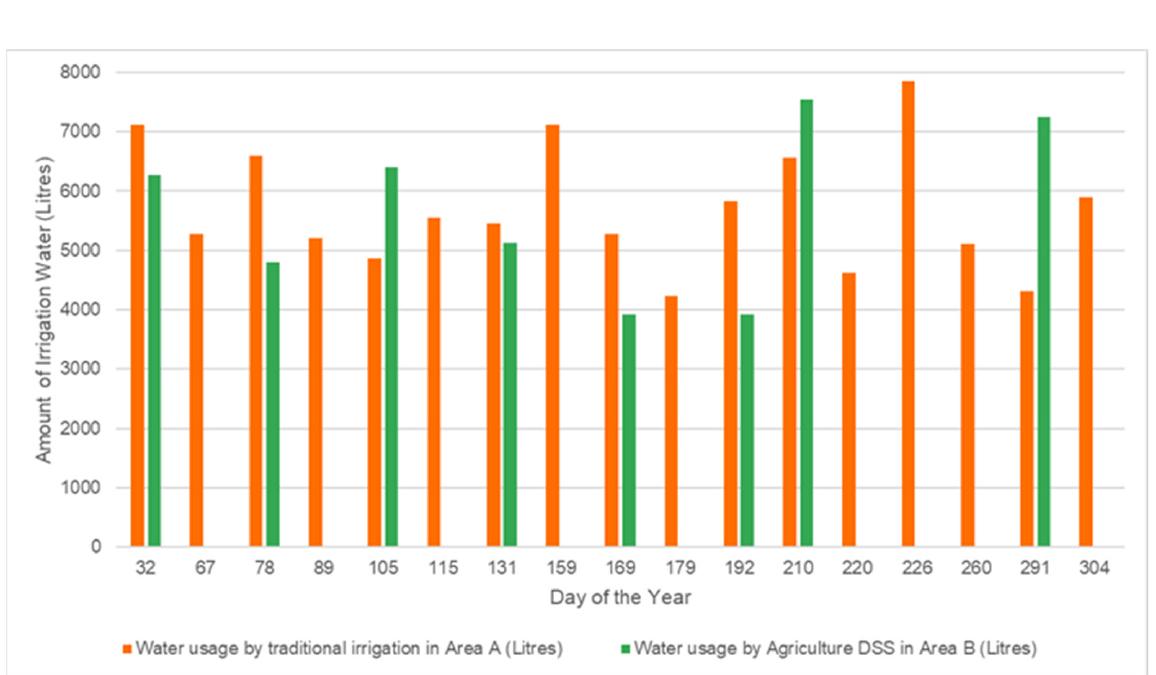
Figure 8. Water usage efficiency of traditional and DSS algorithm-based irrigation systems .